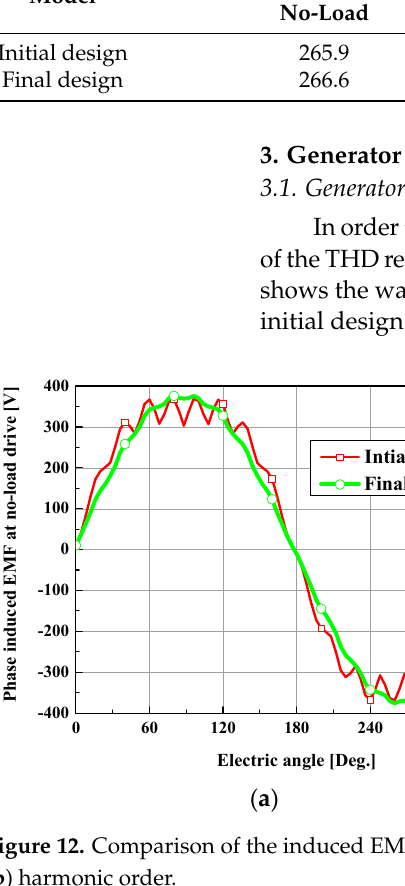
( b ) Figure 13. Induced EMF at no-load and load drives for the final design: ( a ) wave form, and ( b ) harmonic order. In order to verify the characteristics of the PMSG for the final design in Figure 11, the dq equivalent circuit was used as shown in Figure 14. The dq equivalent circuit has the strength of being able to analyze the characteristics of the PMSG with direct current (DC) circuits, as compared to an analysis of alternating currents for the 3-phase model [21]. ( a ) ( b ) Figure 14. Equivalent circuit: ( a ) d axis, and ( b ) q axis.